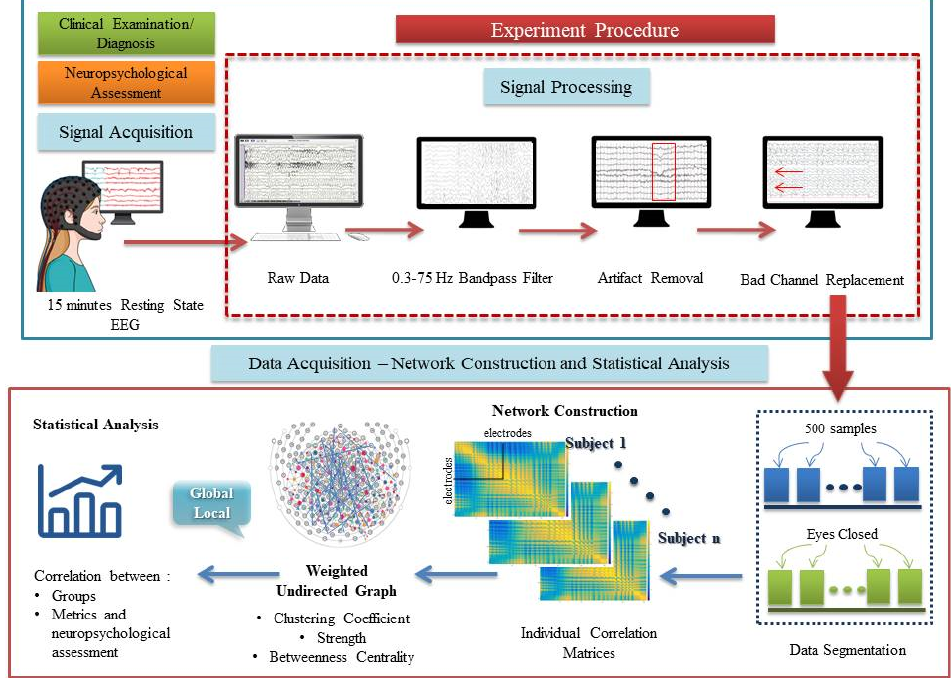
Figure 1. Outline of the methodology for extracting the network metrics derived from correlation matrices